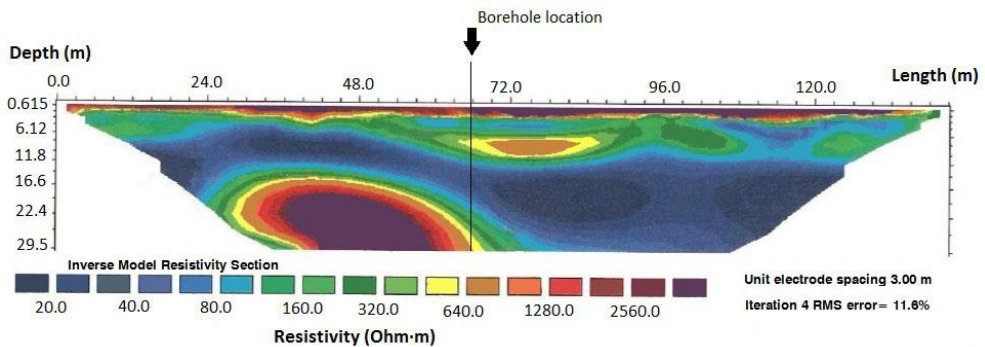
Figure 6. 2D electrical resistivity tomography in the area under study.